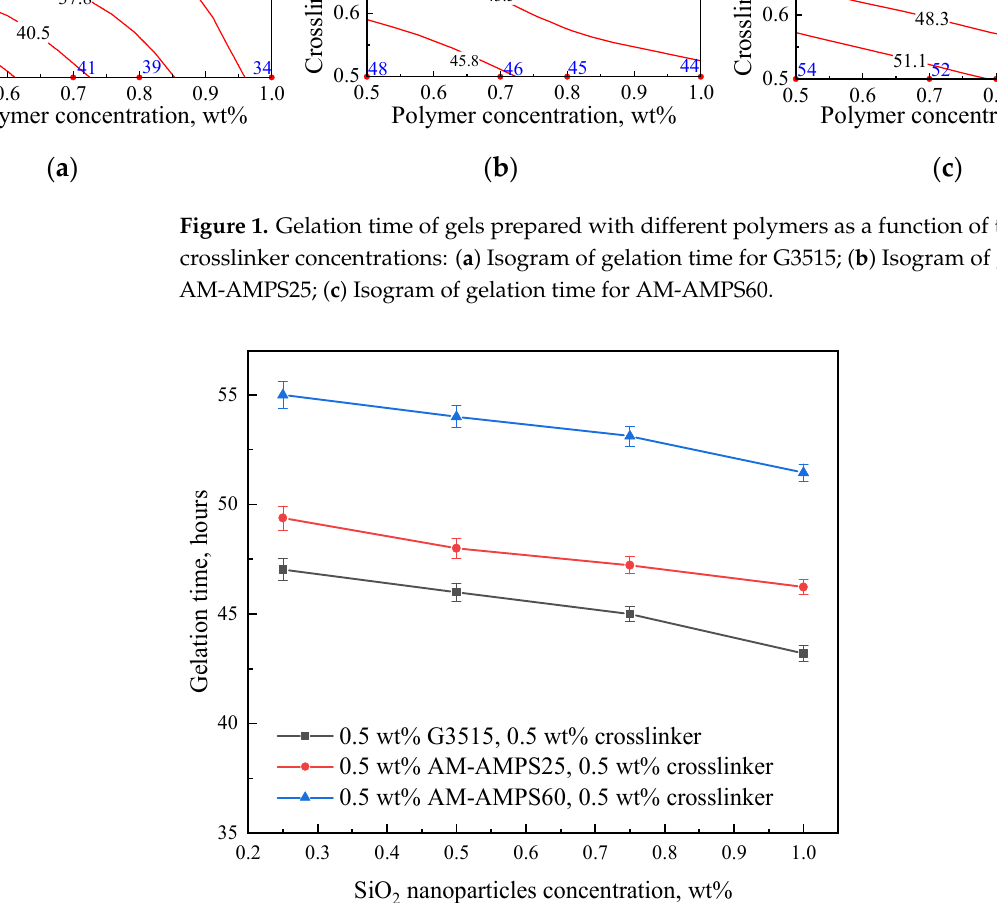
Figure 2. Gelation time of gels prepared with different polymers and SiO 2 nanoparticle concentrations. (The polymer and crosslinker concentrations were fixed at 0.5 wt%). The gelation time decreased as the polymer, SiO 2 nanoparticle, and crosslinker con- centrations increased. For AM-AMPS25 and AM-AMPS60, the gelation time was longer than that of G3515 under the same polymer and crosslinker concentrations in the gelant. This result can be explained based on the condensation reaction of the amide groups on the polymer backbone with the hydroxyl methyl on the phenolic resin backbone. When the hy- droxyl methyl groups are in the ortho and para positions of the phenol ring, a condensation reaction easily occurs [26]. The steric hindrances of the AMPS group on the copolymer chain and its electrostatic repulsion to the hydroxyl methyl group on the crosslinker molecule, which is electronegative, inevitably decrease the condensation reaction rate (Figure